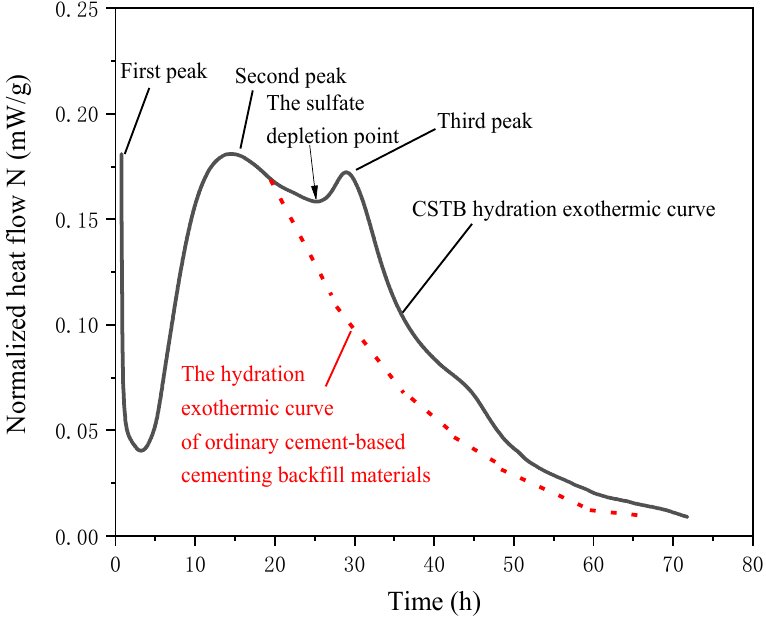
Figure 4. Differ exothermic hydration curves between ordinary cement-based materials [59] and CSTB. Figure 5 is the hydration reaction exothermic rate curve of different TCRs under the same SC and the total exothermic amount curve of SC = 72%. Table 2 indicates the specific changes in the hydration heat evolution of different TCRs under SC = 72%.